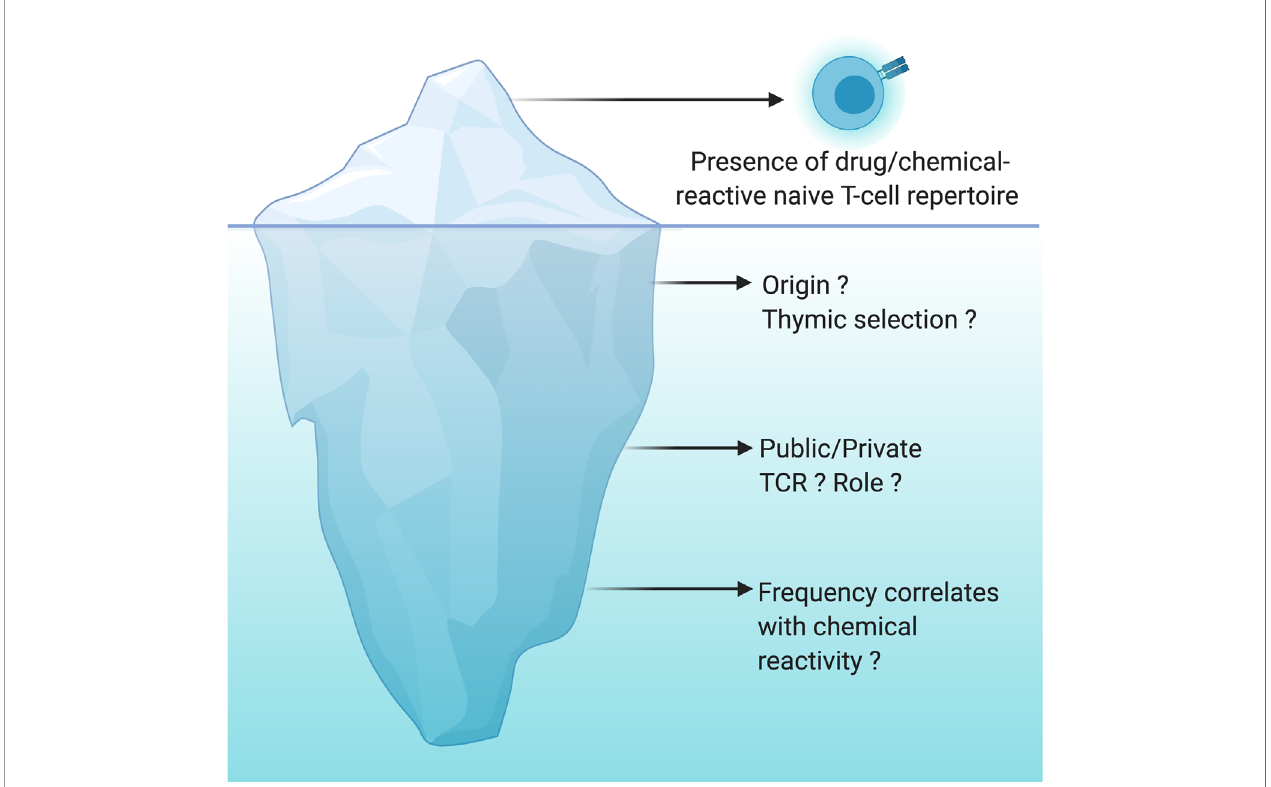
FIGURE 2 | Drug/chemical-reactive naive T-cell repertoire: the tip of the iceberg. The naive T-cell repertoire of every individual harbors T cells able to recognize drugs and chemicals of different origins and structures. This concept is now well recognized and accepted but is only the tip of the iceberg. However, the origin of these T cells, the nature of their TCR (public vs private) as well as the correlation between their frequency and their chemical reactivity are still largely unknown. The origin of these cells is not yet clearly determined, cross-reactivity with viral antigens or speci fi c recognition of the chemical moiety bound to a self-peptide are a working hypothesis. Do we have speci fi c TCRs that will be more likely to expand depending on the type of recognition by TCRs (peptide-drug bioconjugates and hapten, pi-concept)? Is the frequency of naïve T cells speci fi c for drugs and chemicals very different between individuals? Is the frequency of these T cells constant with time suggesting a constant thymic selection of T cells capable of expanding upon recognition of a drug or a chemical? All these questions are still open and are the unknown part of the